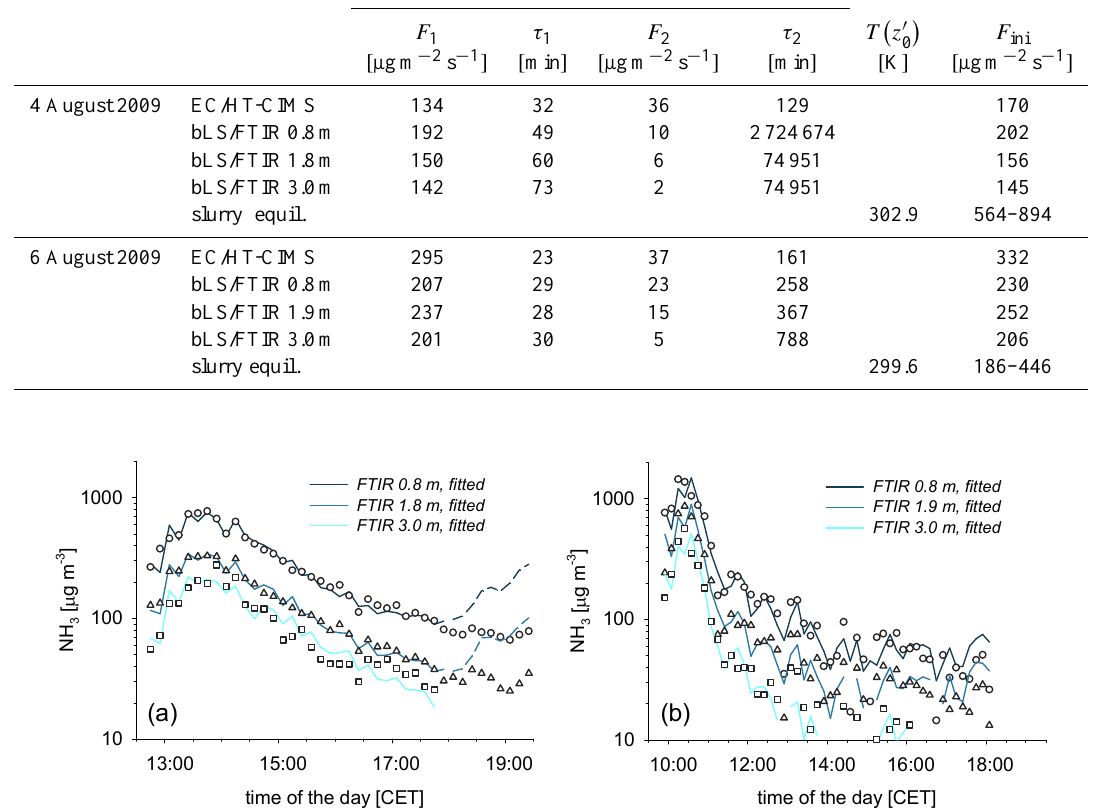
(cid:1) ), and the according initial NH 3 fluxes 0 fitted function parameters